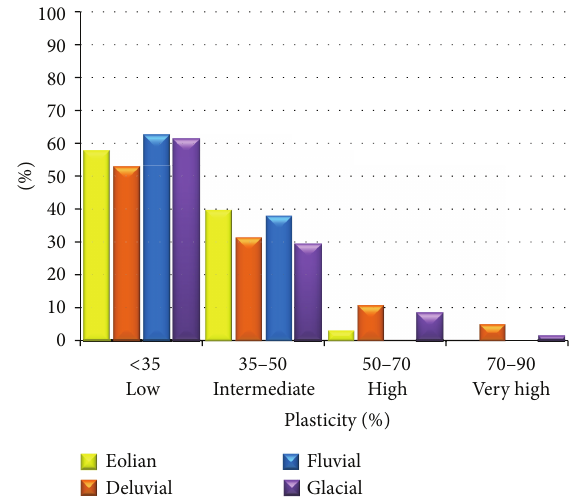
Figure 6: Percentages of the plasticity degrees in the individual genetic types.